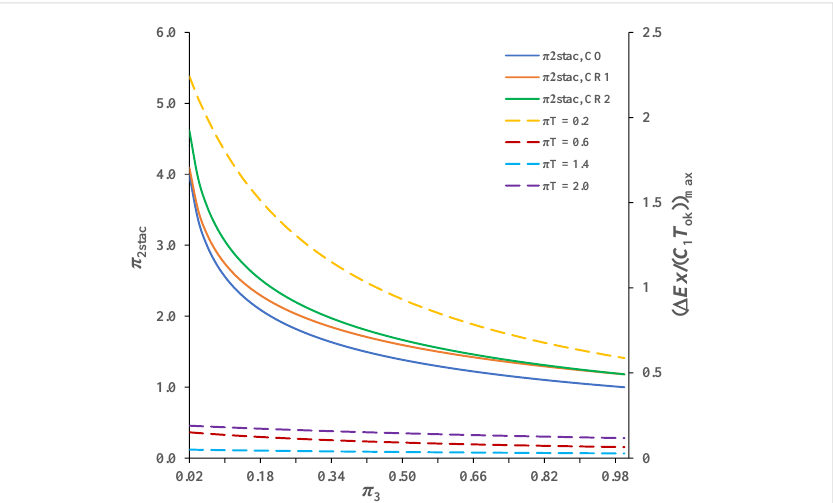
∆ Ex /( C 2stac and ( 1 T ok )) max on π T and π 3 .